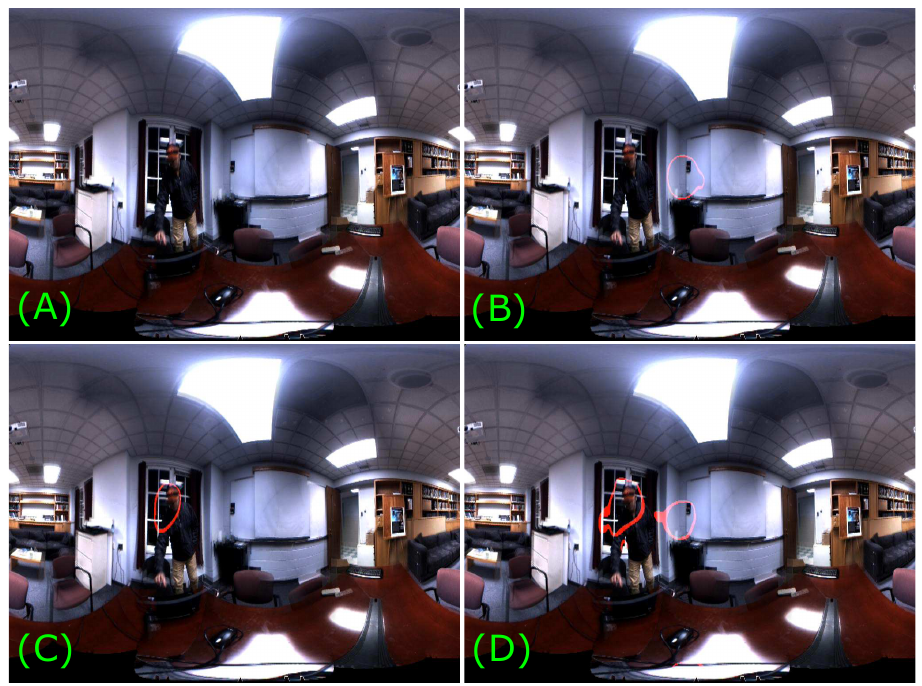
Figure 12. Comparison of AVSM with unisensory saliency maps: ( A ) input Frame #393 of Dataset 1; ( B ) ASM detects the salient auditory event, but misses the salient visual motion; ( C ) VSM correctly detects the salient motion event, but misses the salient audio; and ( D ) AVSM 1 captures both valid salient events from two different sensory